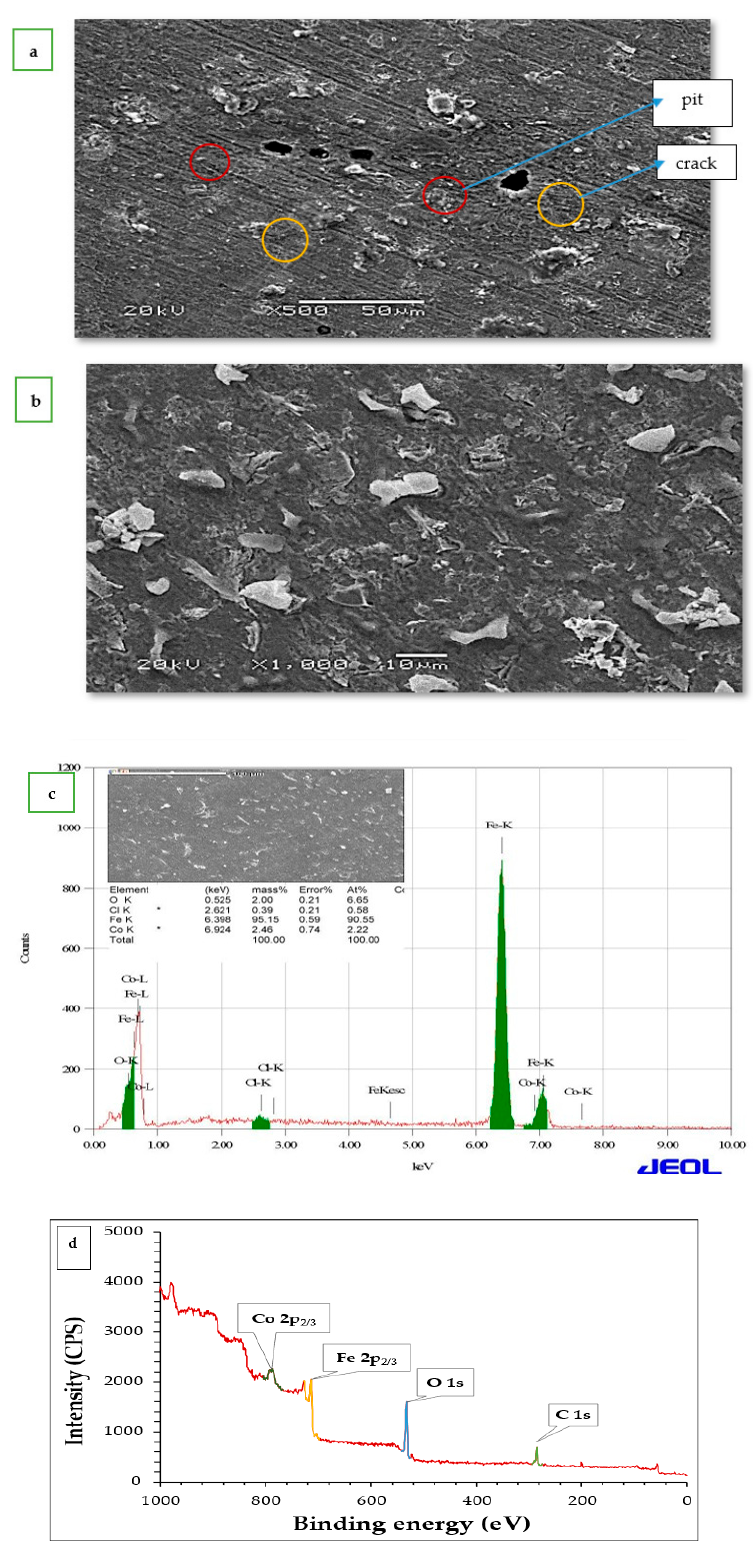
Figure 10. SEM image of low-carbon steel corrosion in 1 M HCl in the blank ( a ), SEM image ( b ), EDS spectra ( c ), and XPS ( d ) of low-carbon steel corrosion in 1 M HCl in the absence and presence of 40 ppm CoO/Co 3 O 4 NPs.